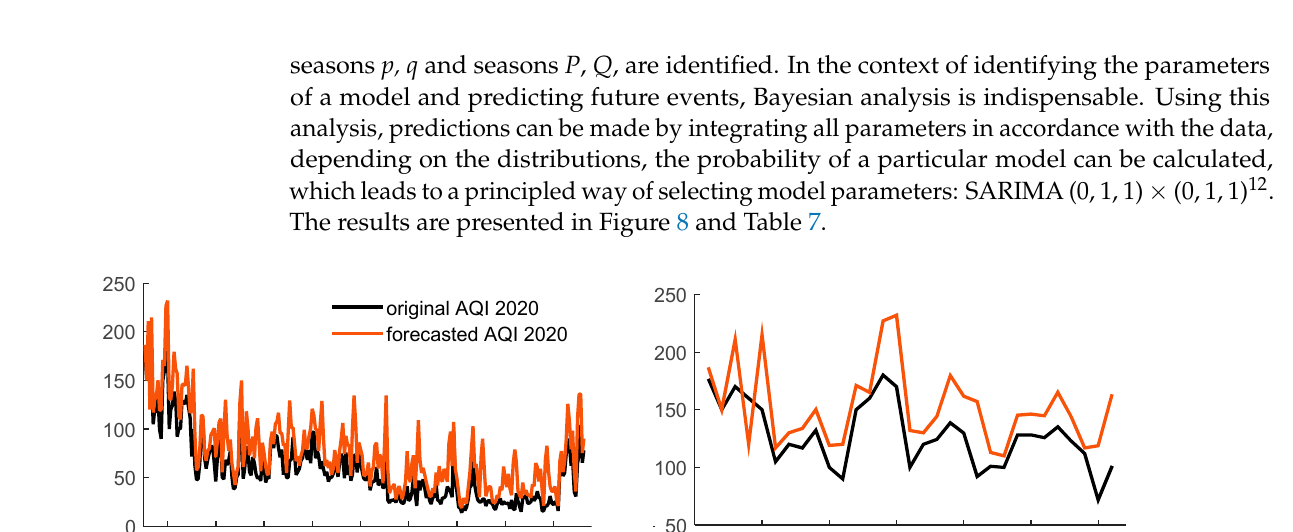
Figure 7. IMFs and residual of the AQI time series from 2015 to 2019.